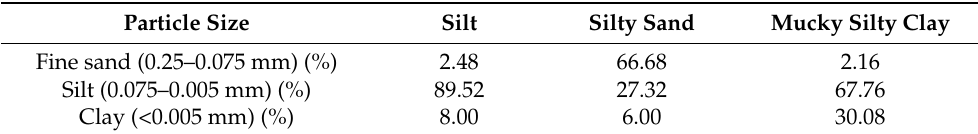
Figure 2. Sampling sites. Table 1. Particle size distribution of soil.